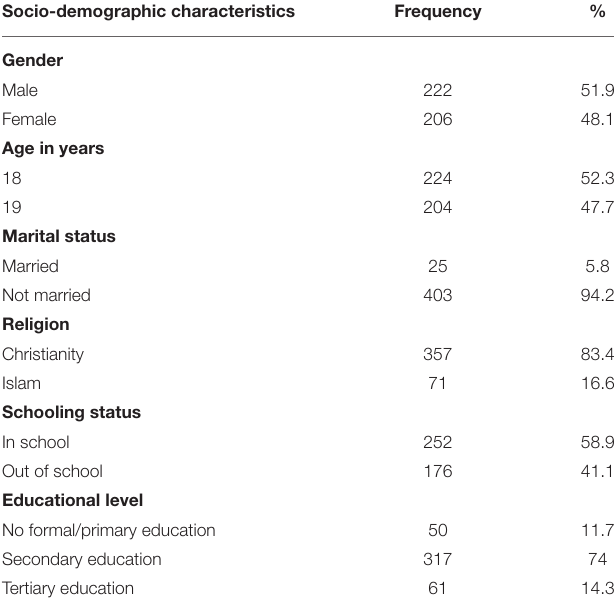
TABLE 1 | Socio-demographic characteristics of participating adolescents in Plateau State, Nigeria ( N = 428). Socio-demographic characteristics